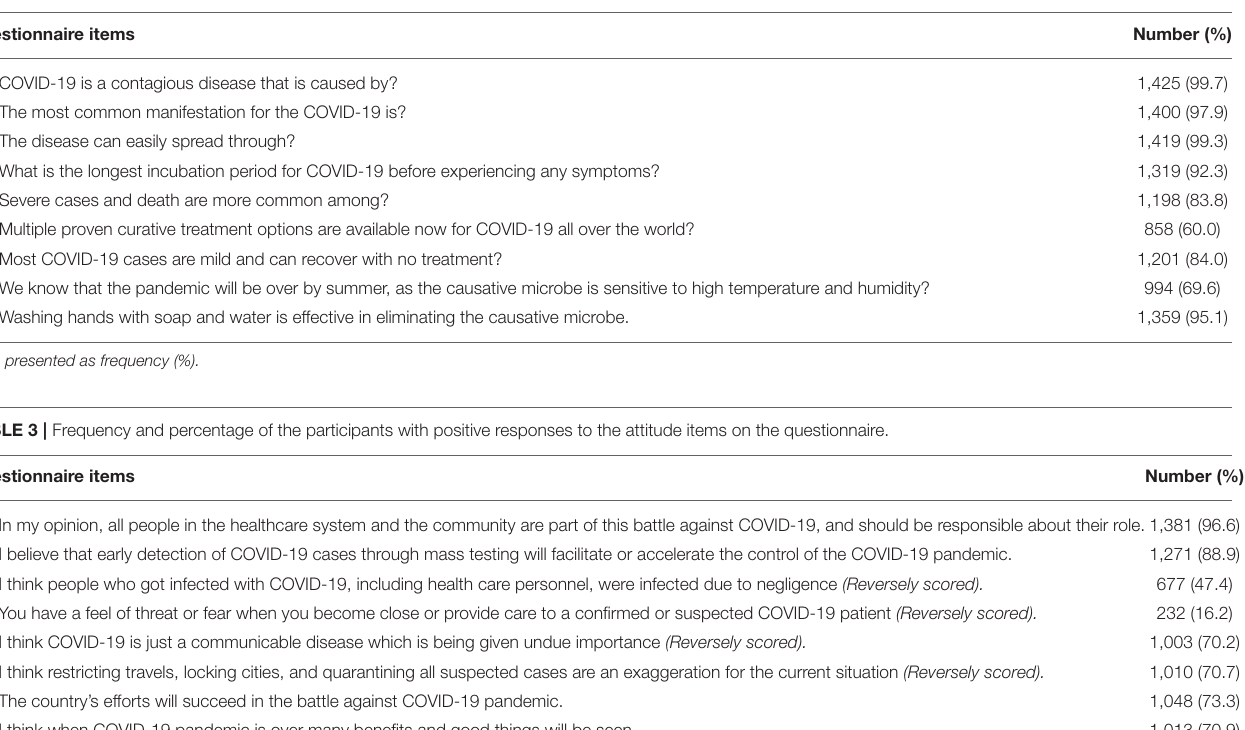
TABLE 2 | Frequency and percentage of the participants with correct responses to the knowledge items on the questionnaire.